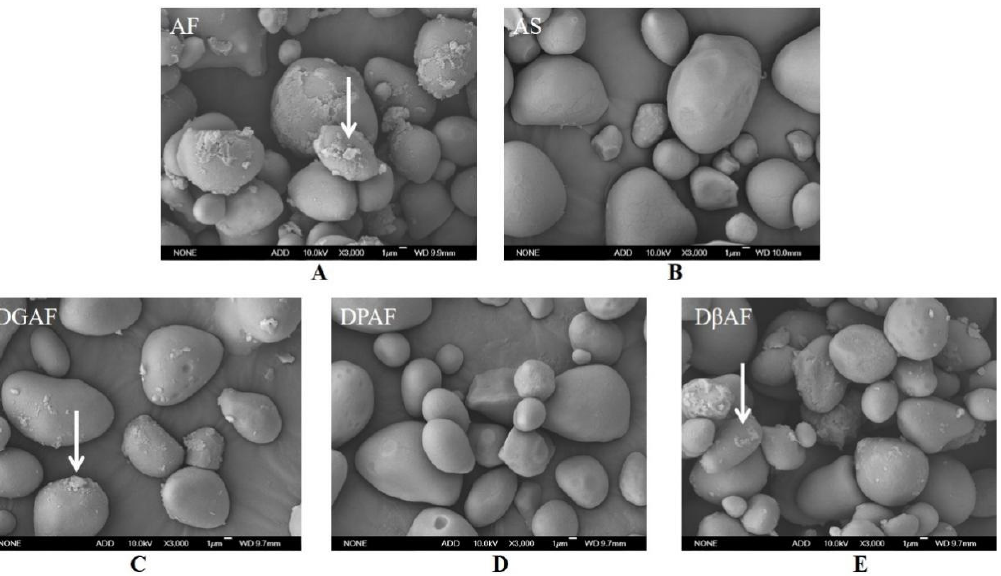
Figure 1. SEM images of AF and after removal of non-starch nutrients ( × 3000). ( A ) AF, acorn flour; ( B ) AS, acorn starch; ( C ) DGAF, degreased acorn flour; ( D ) DPAF, deproteinized acorn flour; ( E ) D β AF, de- β -glucan acorn flour.